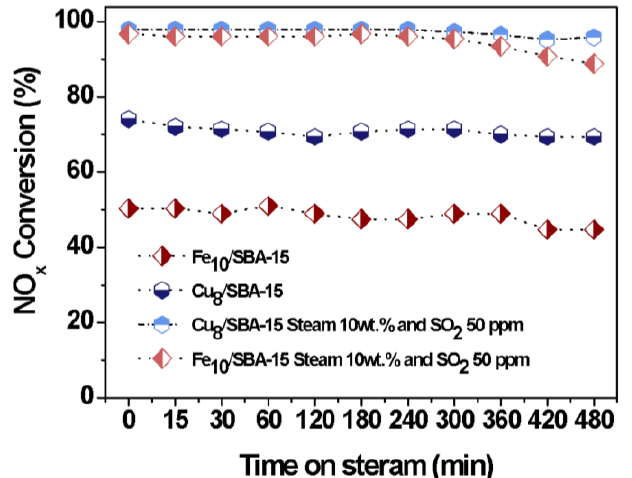
Figure 10. NO x conversions as a function of the time on steam in the presence of distinct poisons : Steam 10 wt.%, SO 2 50 ppm and both steam 10 wt.% and SO 2 50 ppm.